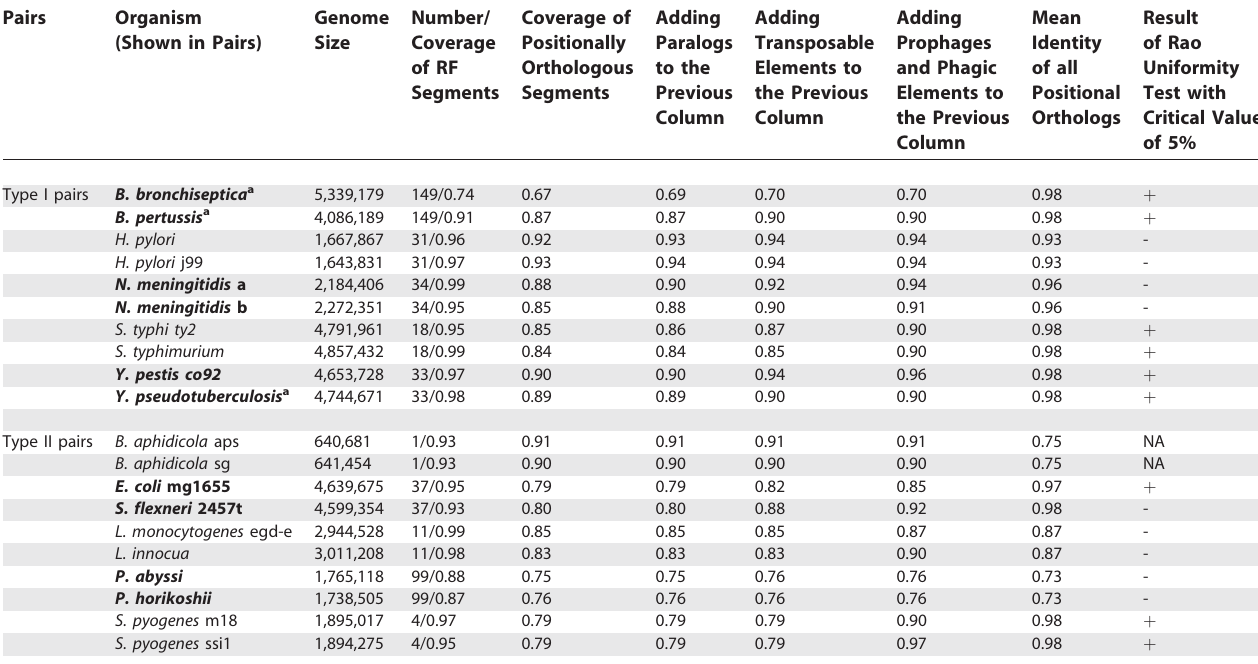
Table 2. Pairwise Comparison Statistics Pairs Organism (Shown in